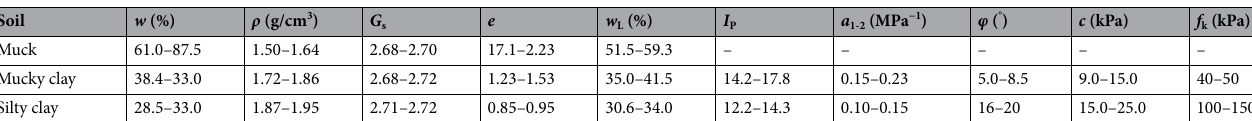
Table 3. Parameters of the weak foundation along the widened expressway.